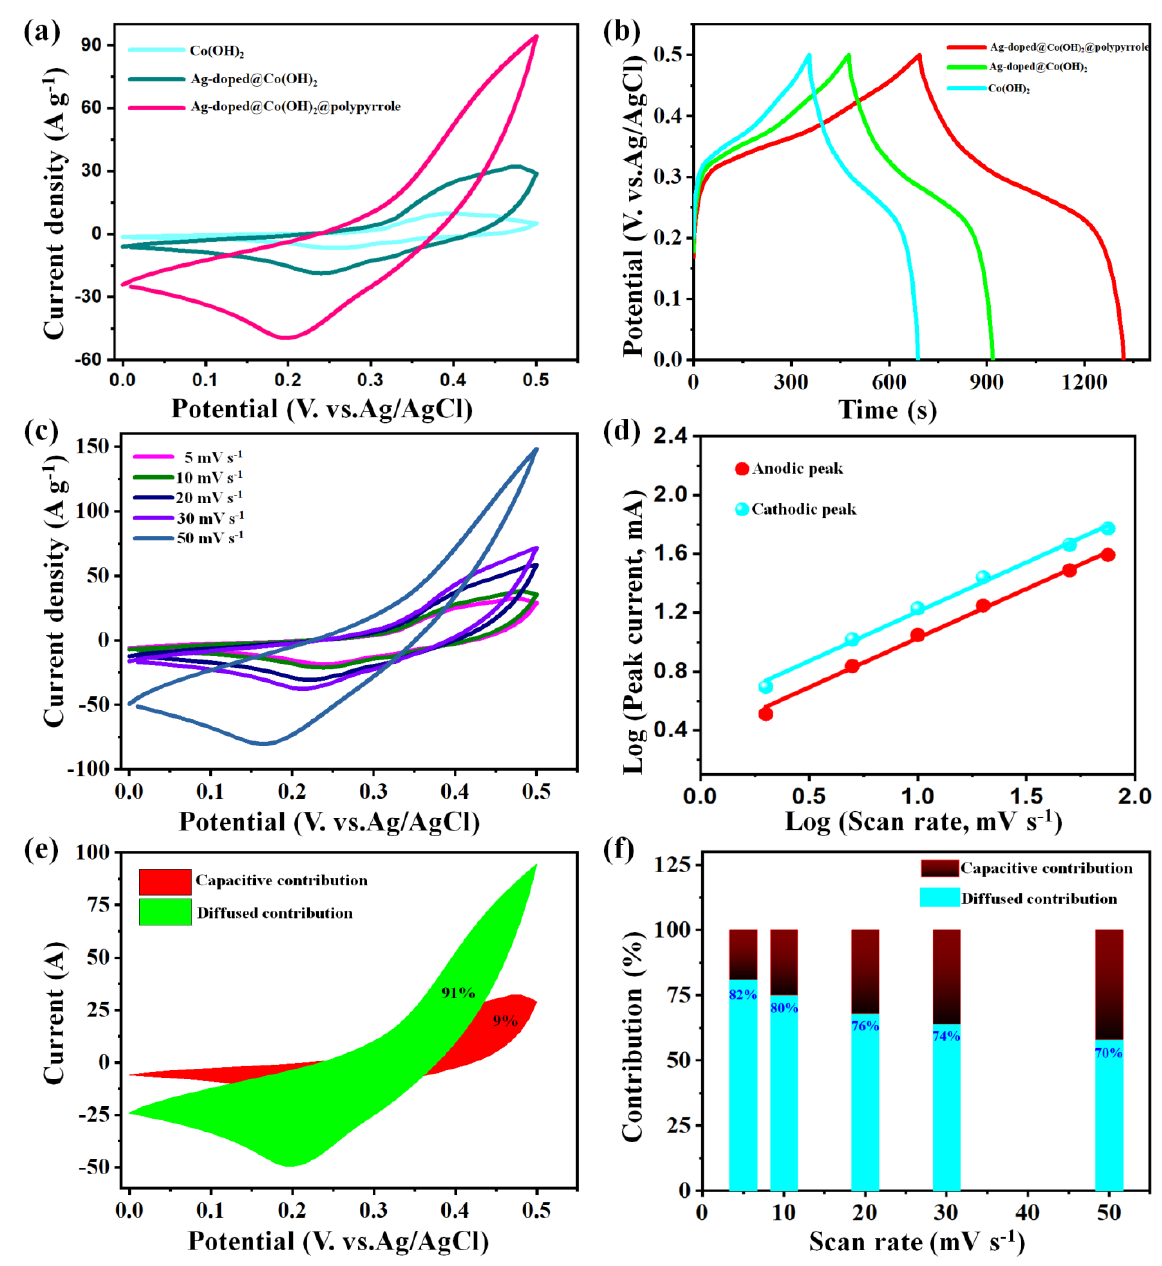
Figure 5. CV data at 5 mV s −1 ( a ) and GCD data at 2 A g −1 ( b ) of Co(OH) 2 nanoparticles, Ag- doped@Co(OH) 2 NPs, and Ag-doped@Co(OH) 2 @polypyrrole NS electrodes; CV curves ( c ) and log( i ) vs. log( v ) plots ( d ) of the Ag-doped@Co(OH) 2 @polypyrrole NS electrode; diffusion and capacitive contributions of the Ag-doped@Co(OH) 2 @polypyrrole NS electrode at 5 mVs −1 ( e ); charge storage contributions of the Ag-doped@Co(OH) 2 @polypyrrole NS electrode at various scan rates ( f ). The possible redox mechanism of the working electrodes under pure and redox- additive electrolytes is given in Equations (2) and (3)